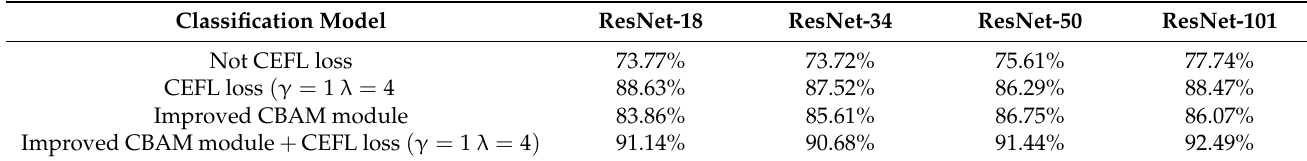
Table 12. F1-score for each classification